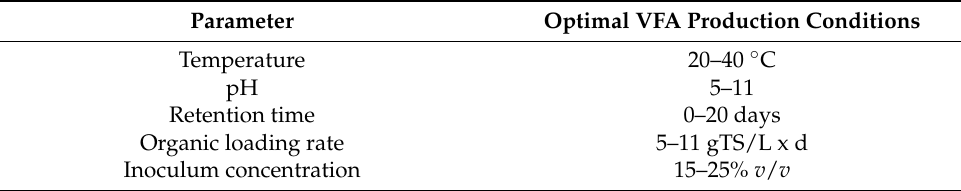
Table 4. Optimal operational conditions for VFA production